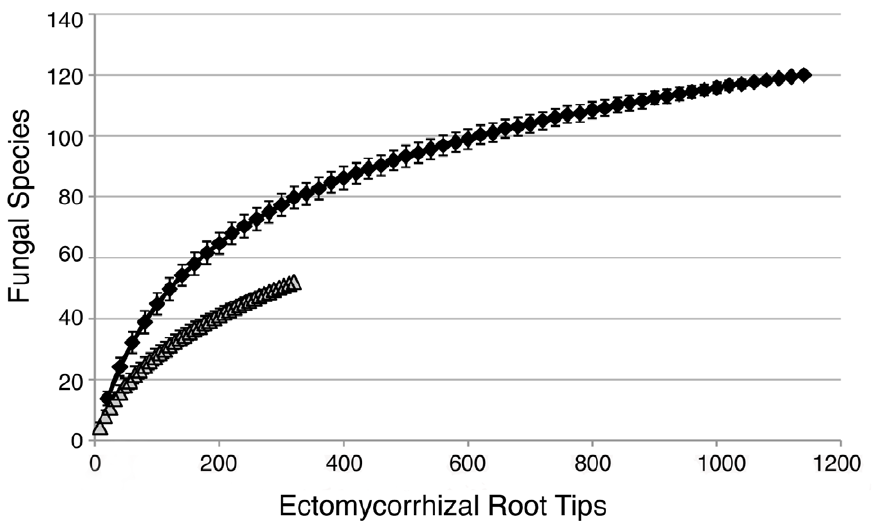
Figure 3. The sampling curves indicate the ectomycorrhizal (ECM) root tips sampled (X-axis) and number of ECM fungal species recovered (Y-axis) from the Pegaima site with Pakaraimaeadipterocarpacea and Dicymbejenmanii (grey triangles, this study) and from the Potaro site with Dicymbecorymbosa , Dicymbealtsonii , and Aldinainsignis (black squares, Smith et al. [ 9 ] ). The two studies differed in their sampling procedure; this study was based on random sampling of eight ECM roots per tree whereas the study by Smith et al. [9] was based on sampling of 20 morphotyped ECM roots per tree.